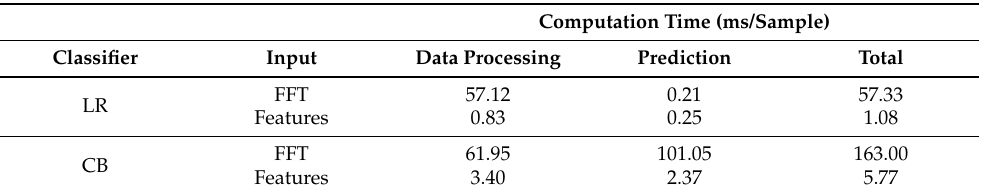
Table 7. The average computation time (including the time required to process input data and run a model to obtain a result) of selected classifiers trained with FFT or feature-based vibration acceleration measurement data. The results are computed using samples in the test dataset.